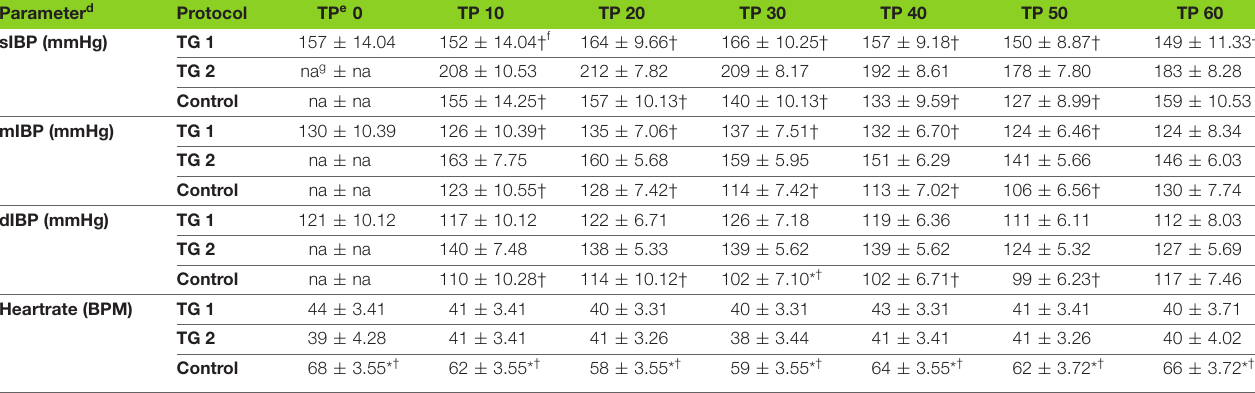
TABLE 6 | Vital parameters of blood pressure and heartrate for TG a 1: ketamine–medetomidine–midazolam–butorphanol (KMMB), TG 2 tiletamine–zolazepam–medetomidine–butorphanol (TZMB), and CG: etorphine–acepromazine–detomidine–butorphanol (EADB) immobilized kulans (Equus hemionus kulan) following recumbency at timepoint 0 for a 60-minute period.